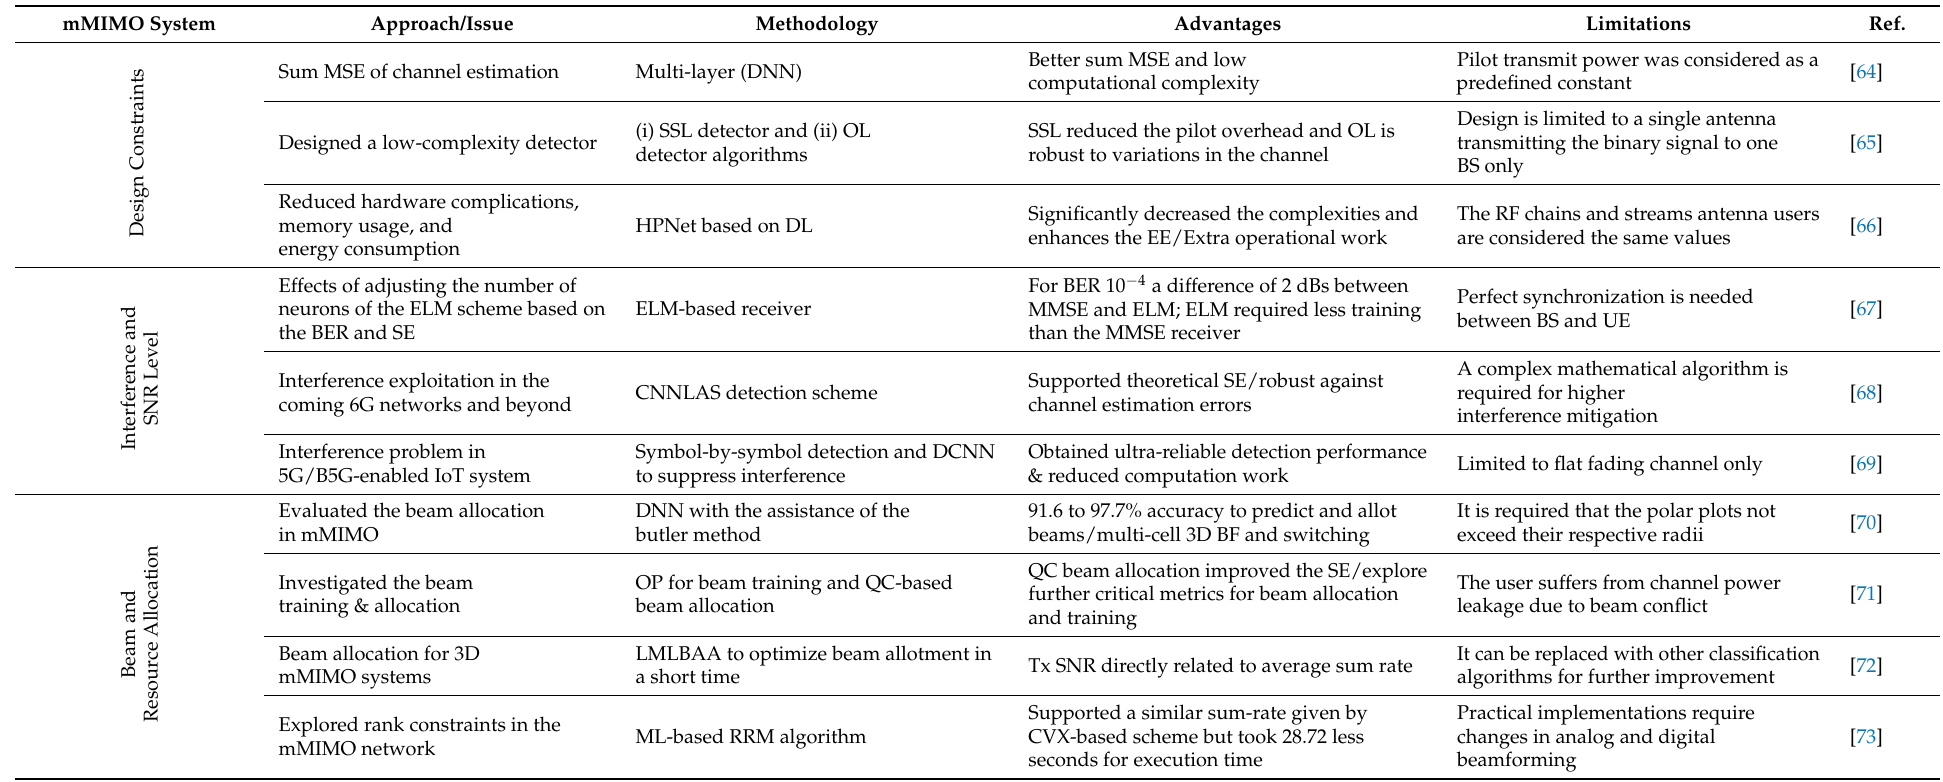
Table 3. A summary of the literature on AI/ML MU-mMIMO